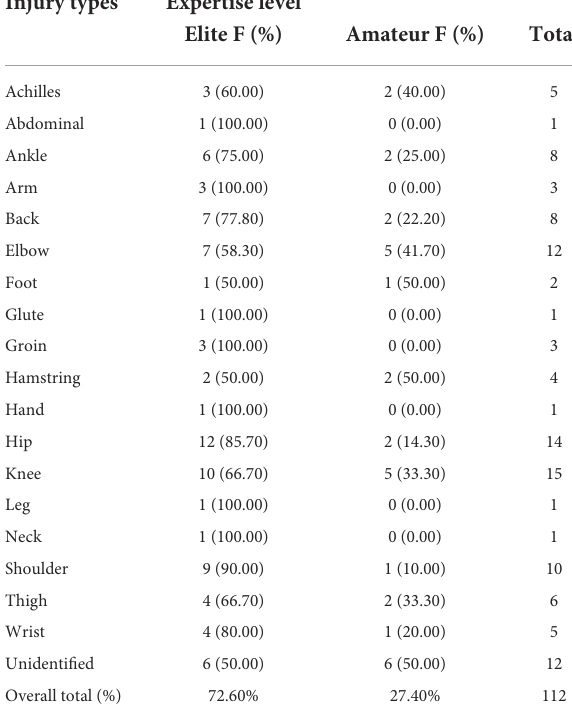
TABLE 1 Injury exposure and level of